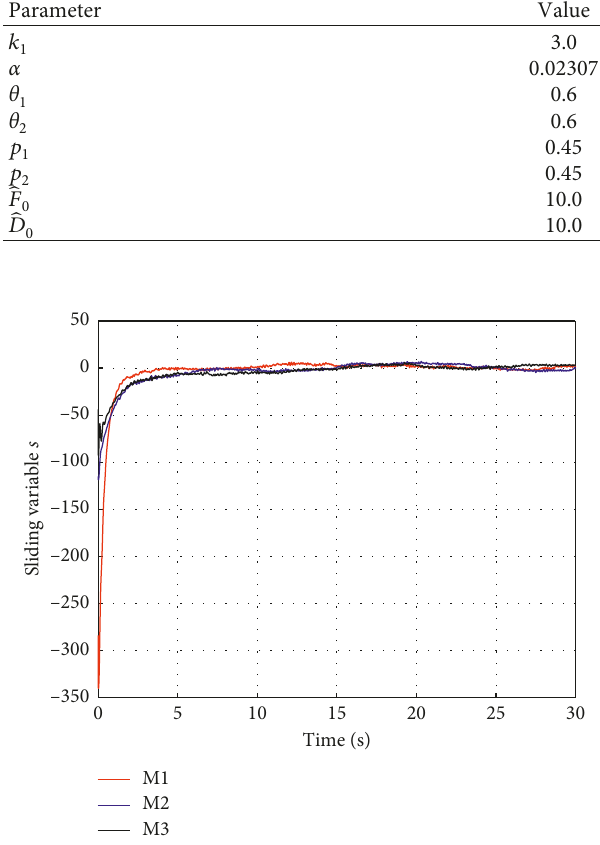
Figure 3: Time response of the sliding variable s under the initial value ( i ) .